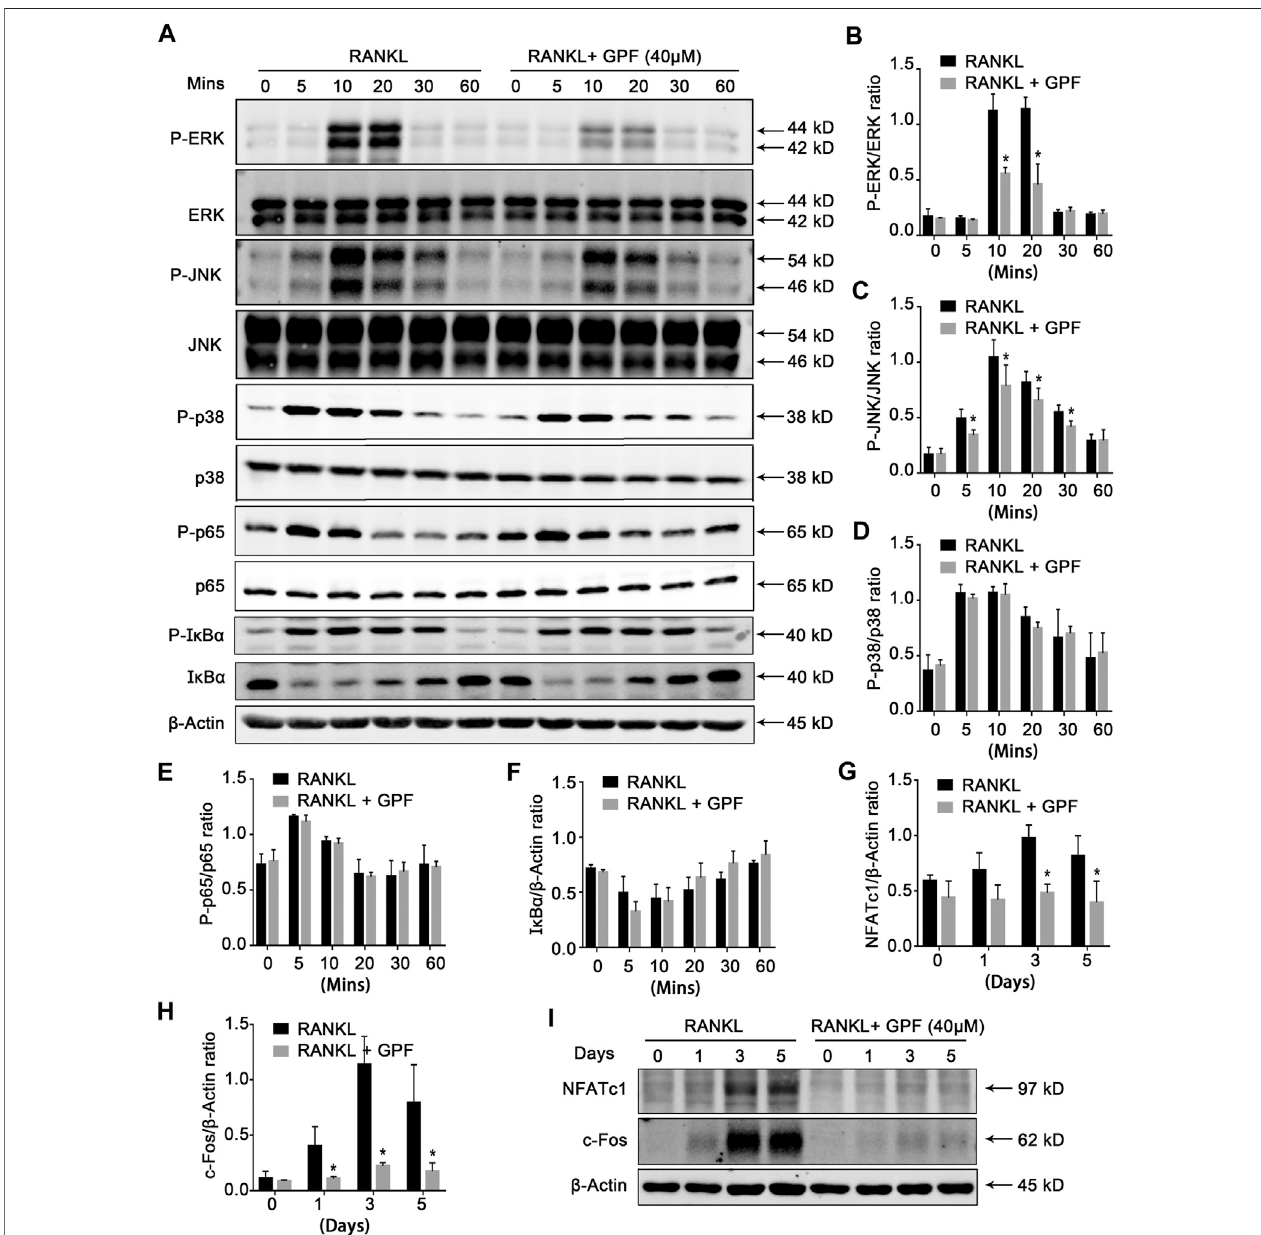
FIGURE 4 | GPF inhibits MAPK, c-Fos and NFATc1 signaling pathways. (A) Representative Western Blot images of the effects of GPF on RANKL-induced activationofMAPK,c-FosandNFATc1signalingpathway.BMMswerepretreatedwith40 μ MGPFfor2 hpriortotheadditionofRANKLattheindicatedtimepointsand the indicated proteins were determined. (B – D) Quantitative analyses of P-ERK, P-JNK and P-p38 were normalized to total ERK, JNK and p38 respectively ( n (cid:2) 3). (E,F) Quanti fi cation of the ratios of band intensity of I κ B α and P-p65 relative to ß-actin ( n (cid:2) 3). (G,H) Quanti fi cation of the ratios of band intensity of NFATc1 and c-Fos relativetoß-actin( n (cid:2) 3). (I) BMMswerestimulatedbyRANKLwithorwithout40 µMGPFfor0,1,3,and5daysforWesternBlot.RepresentativeWesternBlotimagesof the expression levels ofNFATc1and c-Fos. All bar graphsare presented asmean ± SD. * p < 0.05, ** p < 0.01 compared withthe control group(withoutGPFtreatment). All proteins were compared by Student ’ s